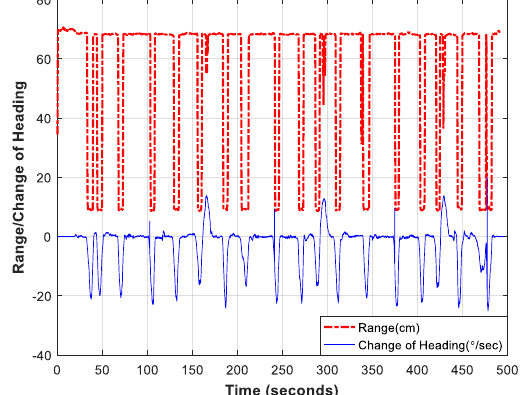
Figure 7. Ultrasonic sensor processed data versus the change of heading from GNSS/INS integration for the dominant left turns category.